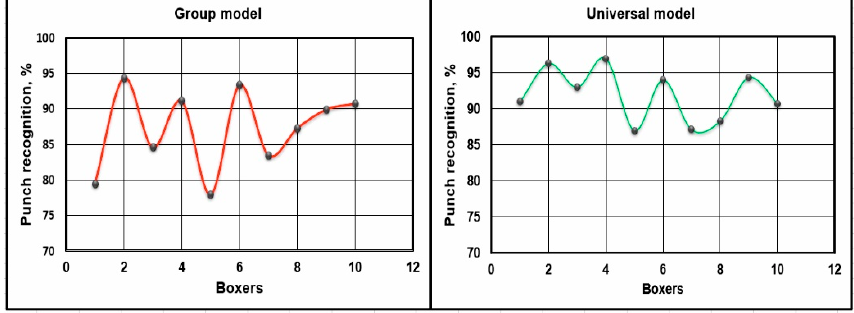
Figure 10. Graphs of the level of recognition of punches of a group of entry-level boxers.